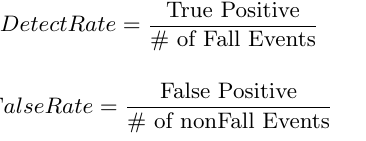
Figure 11: Different falls in the experiments